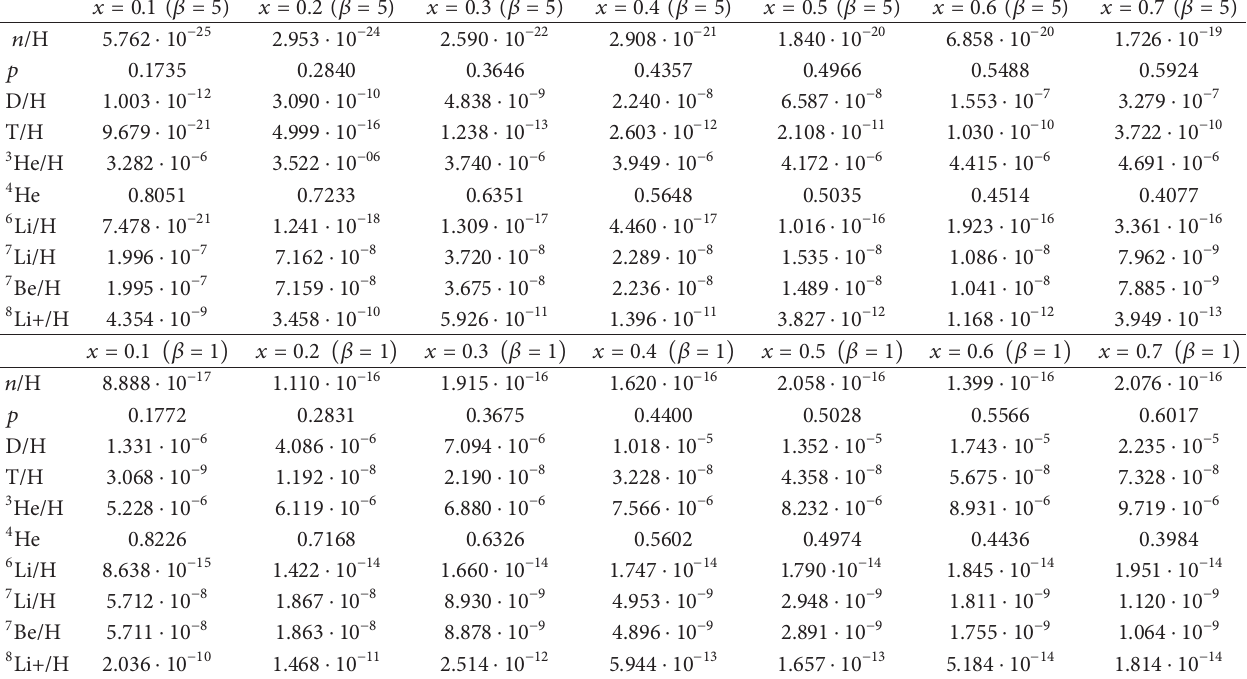
Table 2: Elements produced in the mirror sector. The last row includes all elements with atomic mass larger than 7. 𝑥 = 0.1 (𝛽 =